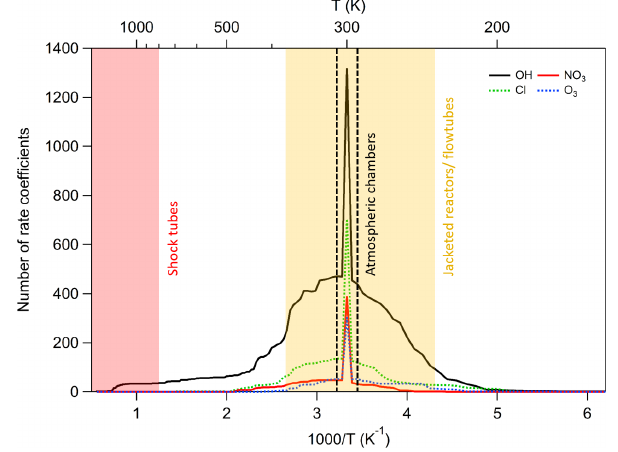
Figure 4. Histograms showing the number of rate coefficients at each temperature, separated by oxidant. A large number of reac- tions have been studied only at room temperature, especially for some oxidants such as NO 3 , where temperature-dependent data are